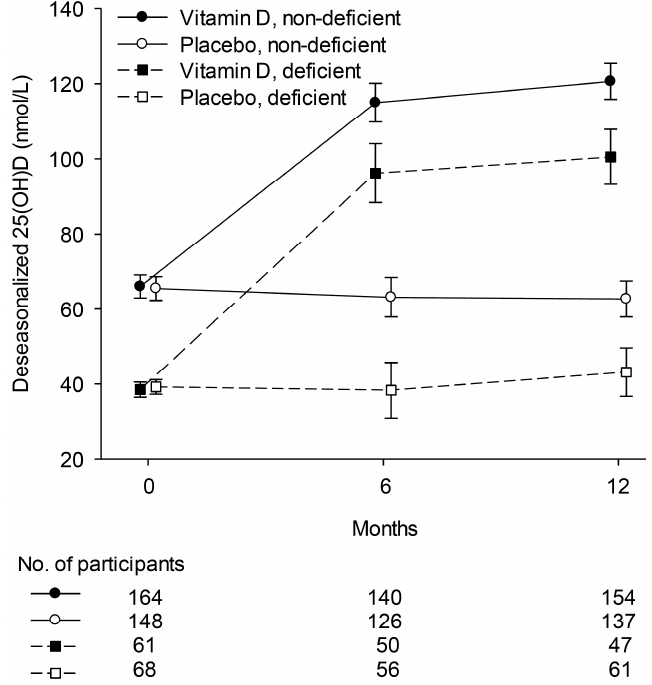
Figure 2. Line graph showing deseasonalised 25(OH)D concentration (mean ± 95% confidence intervals; in nmol/L) at baseline and follow-up (6 and 12 months) in the vitamin D and placebo groups, for non-vitamin D-deficient and vitamin D-deficient people. Baseline 25(OH)D was missing for 1 person (vitamin D group).